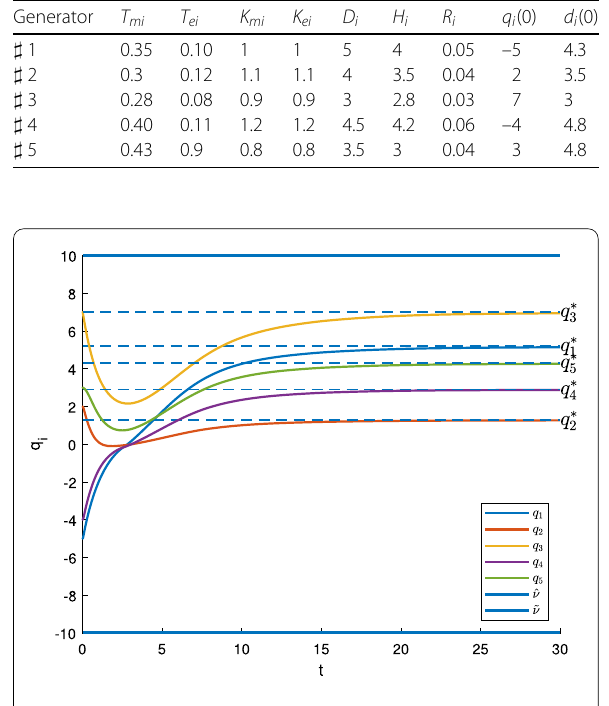
Figure 3 The output power trajectories of generator systems (33a)–(33b) under the proposed